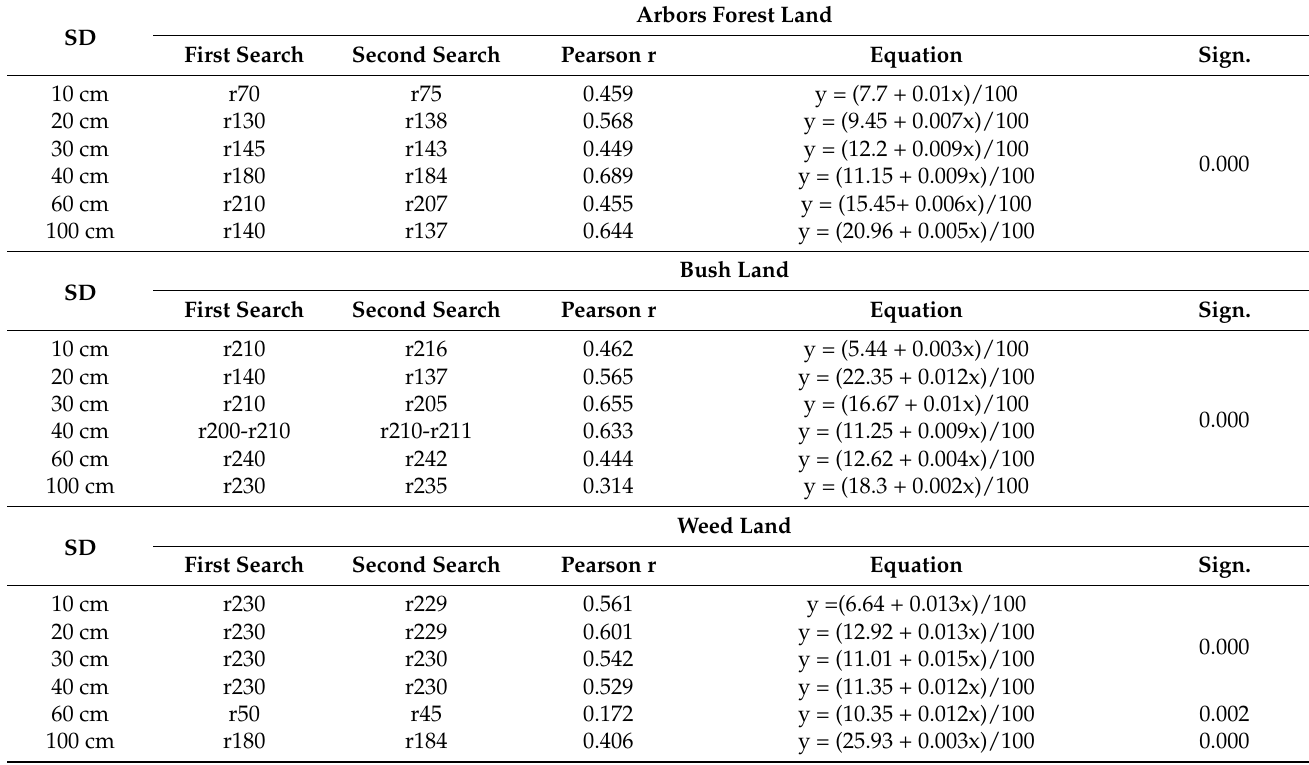
Table 2. The strongest correlation between accumulated precipitation, depth of soil, moisture content, and the linear equation at each layer in three different site types (SD: soil depth, x: Cx’s accumulated precipitation, y: soil moisture